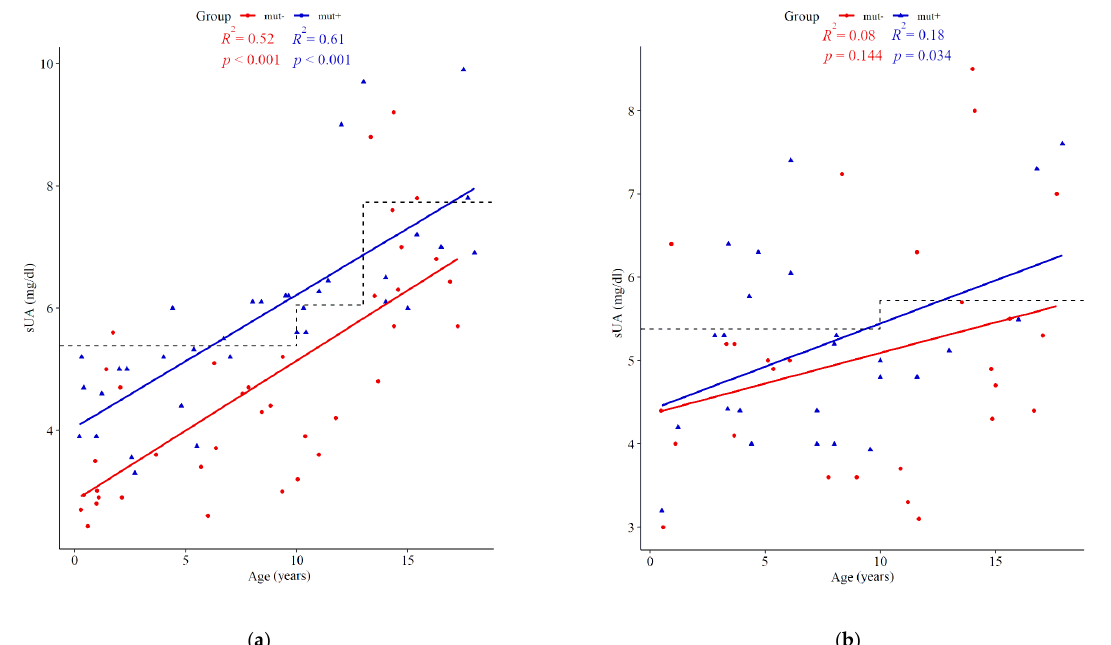
Figure 1. Scatter plots of serum uric acid (sUA) concentrations showing trends with age in children harboring HNF1B mutations (mut+, blue triangles) versus those without mutations (red dots). Boys ( a ) and girls ( b ) are presented separately with age-adjusted upper limits of reference values applied as dashed lines.